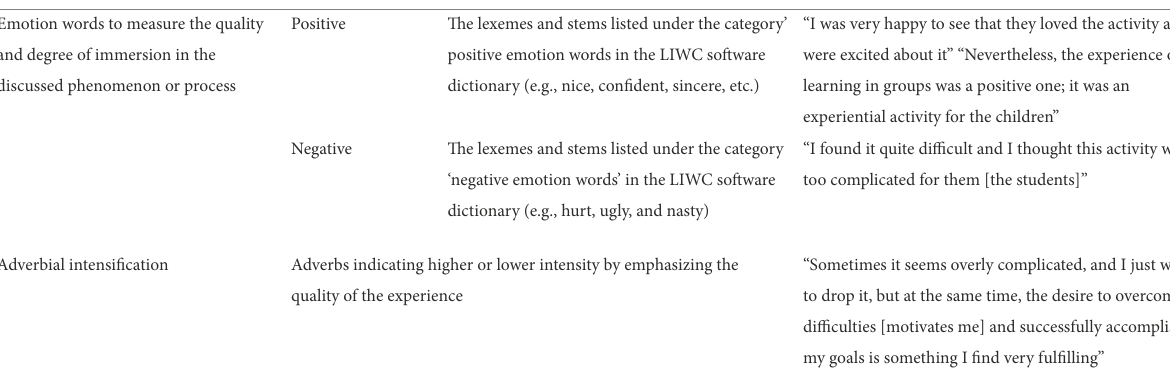
TABLE 2 Linguistic analysis and coding